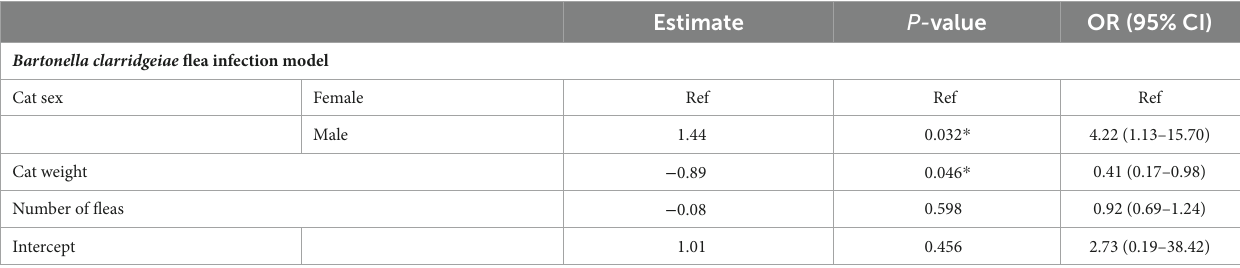
TABLE 4 Summary of the model selected to predict B . clarridgeiae infection in Ctenocephalides felis including only the variables significantly associated with host and flea characteristics and potentially confounding variable (number of fleas per host cat). Estimate